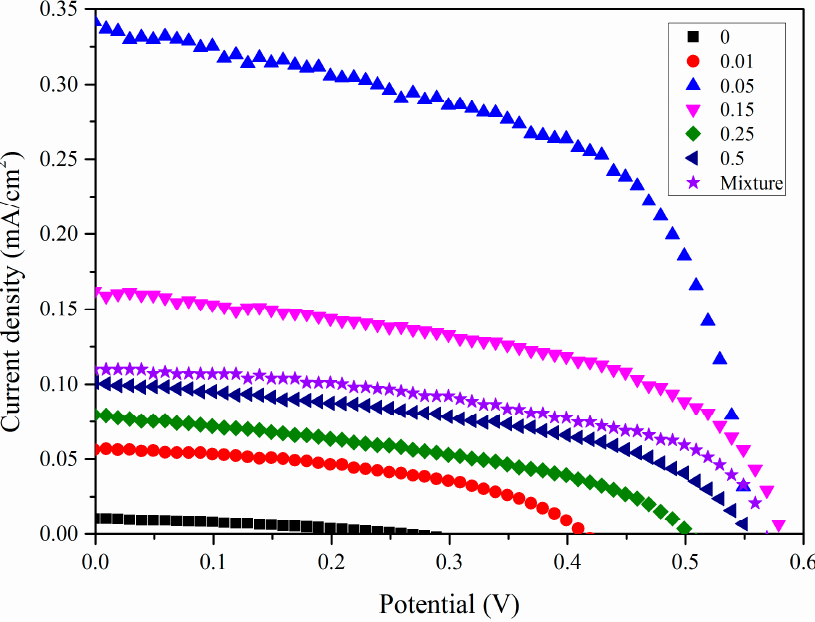
Figure 8. IV curves of a series of Bi 2 O 3 sensitized TiO 2 -based solar cells, as well as a simple mixture of Bi 2 O 3 and TiO 2 -based solar cell.